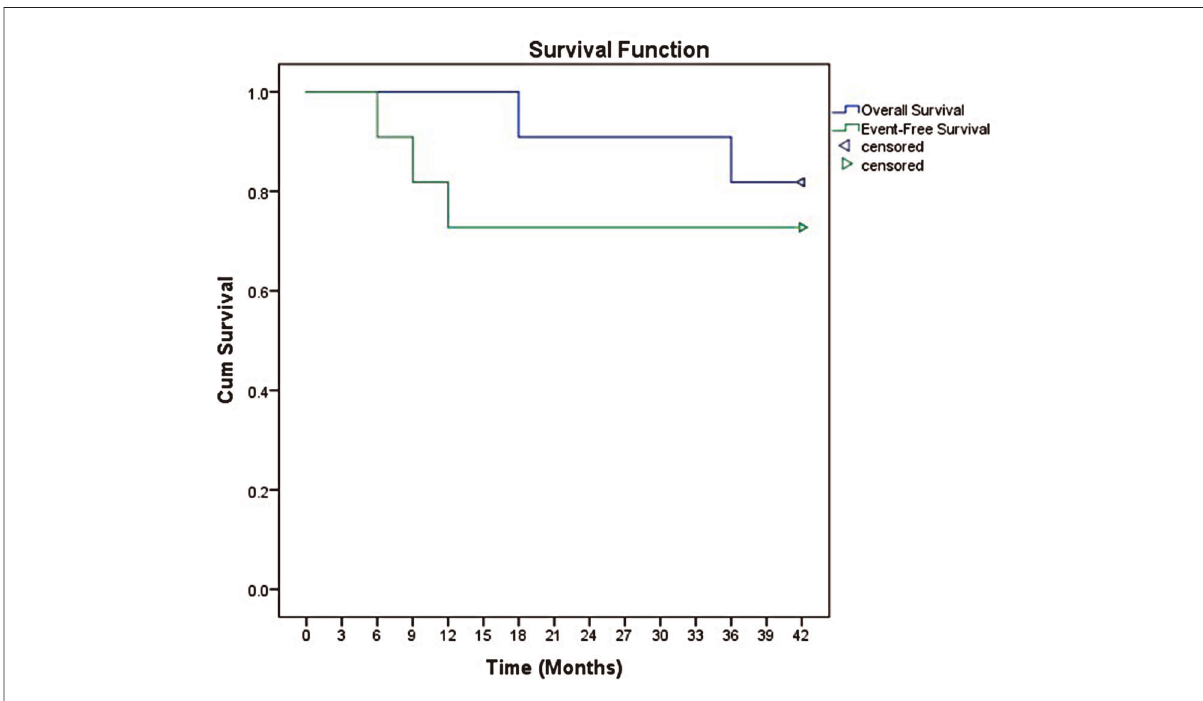
FIGURE 1 The event-free survival and overall survival of